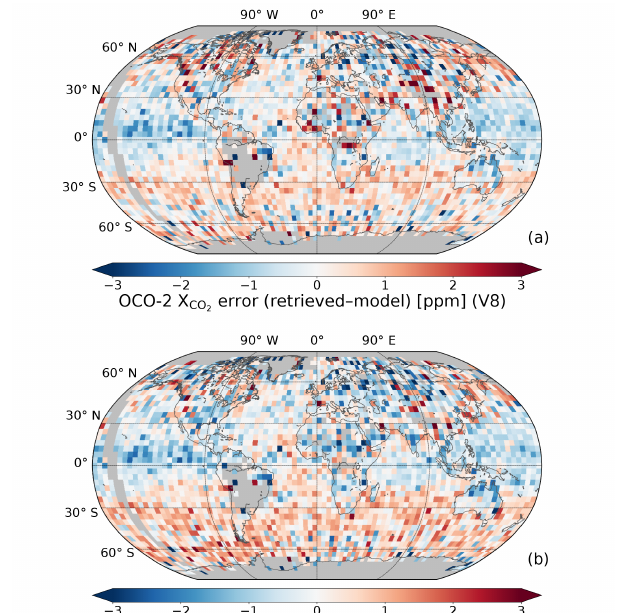
Figure 7. (a) The 4 ◦ × 4 ◦ binned X CO dation for V8. (b) The 4 ◦ × 4 ◦ binned X CO validation for the GEOS-5 types and AODs with low uncertainty. Grey bins represent no data.